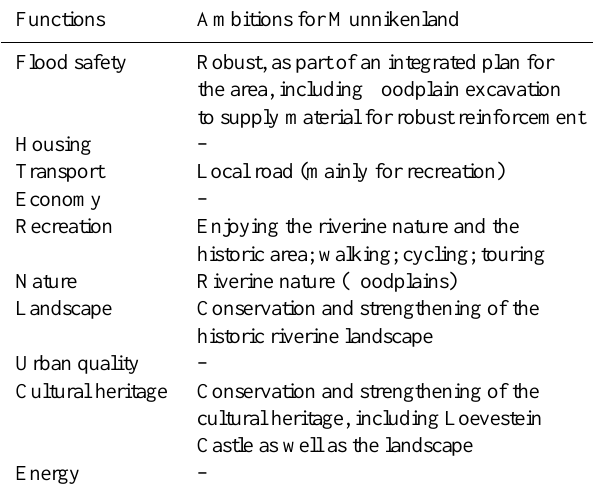
Table 7. Envisaged functions for the Munnikenland